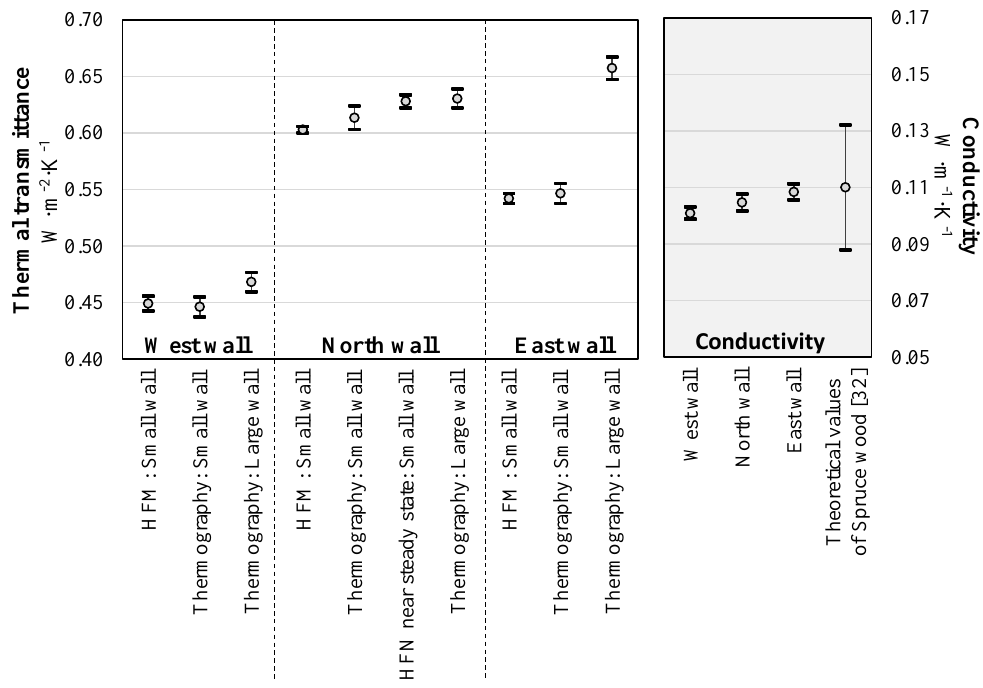
Figure 8. Summary of the main results: the thermal transmittance and the conductivity of the west, north and east walls. Uncertainties of the measurements are represented by the error bars.